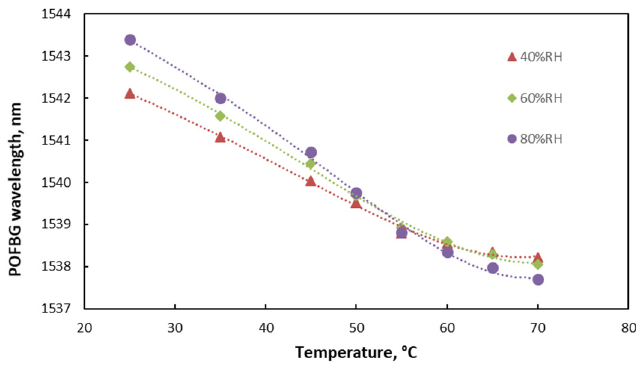
Figure 5. POFBG wavelengths against temperature change at different humidity levels.